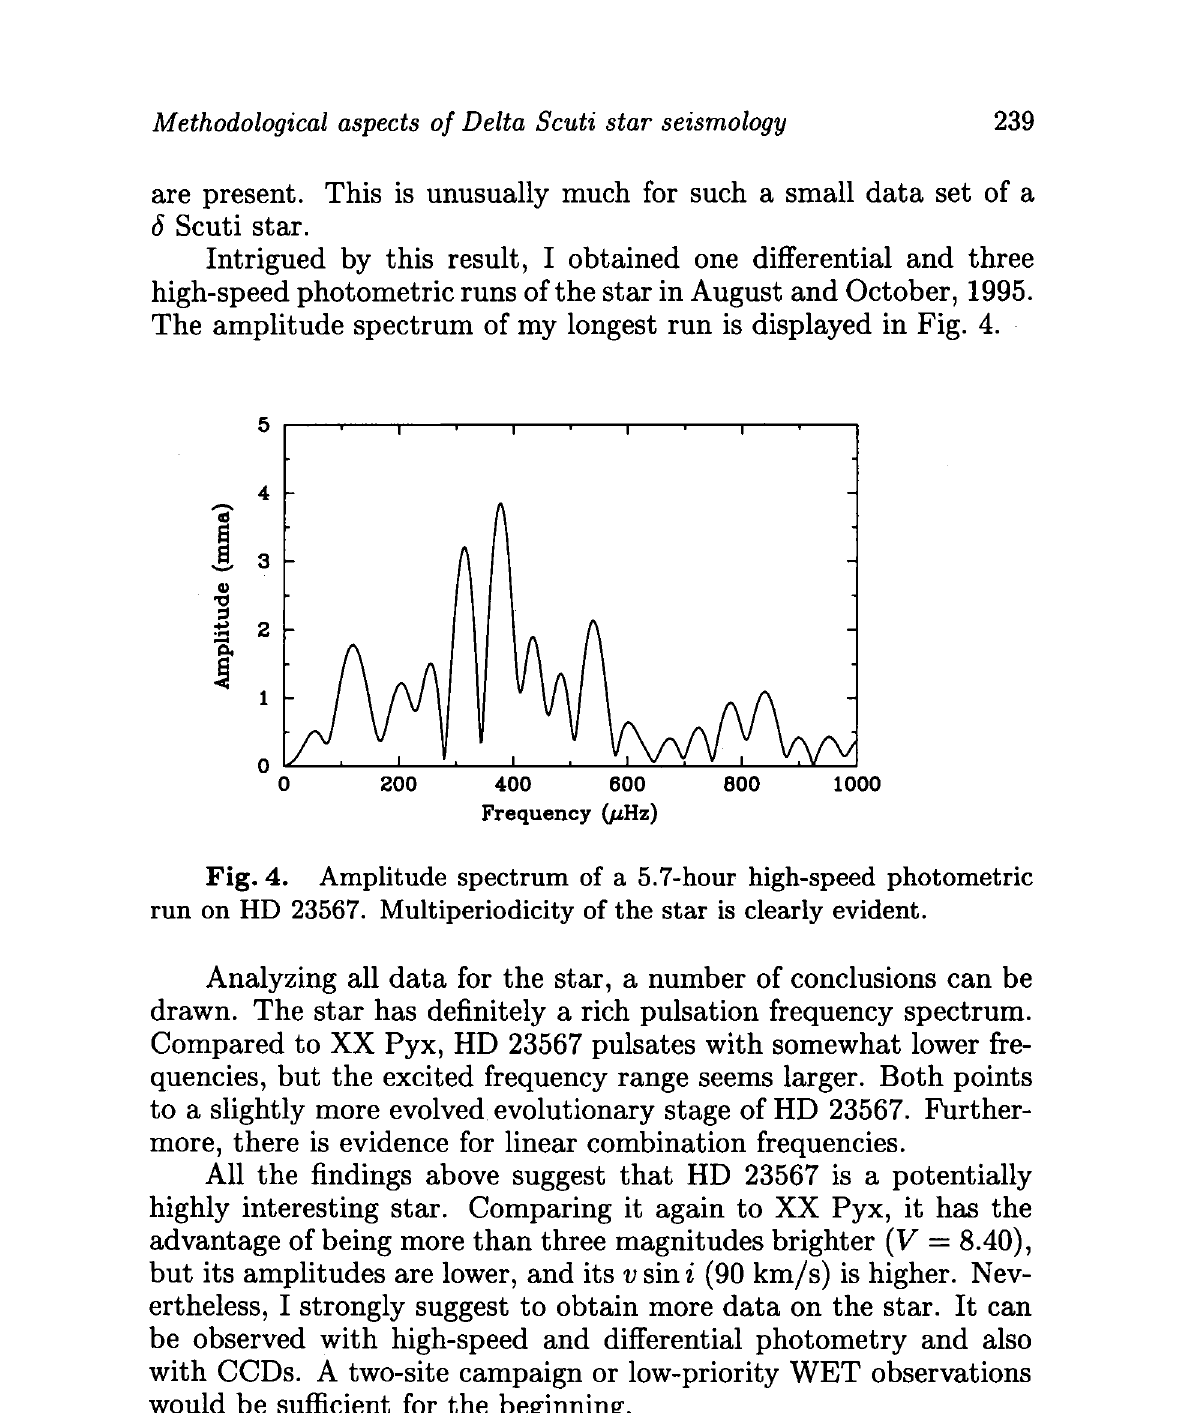
Fig. 4. Amplitude spectrum of a 5.7-hour high-speed photometric run on HD 23567. Multiperiodicity of the star is clearly evident.